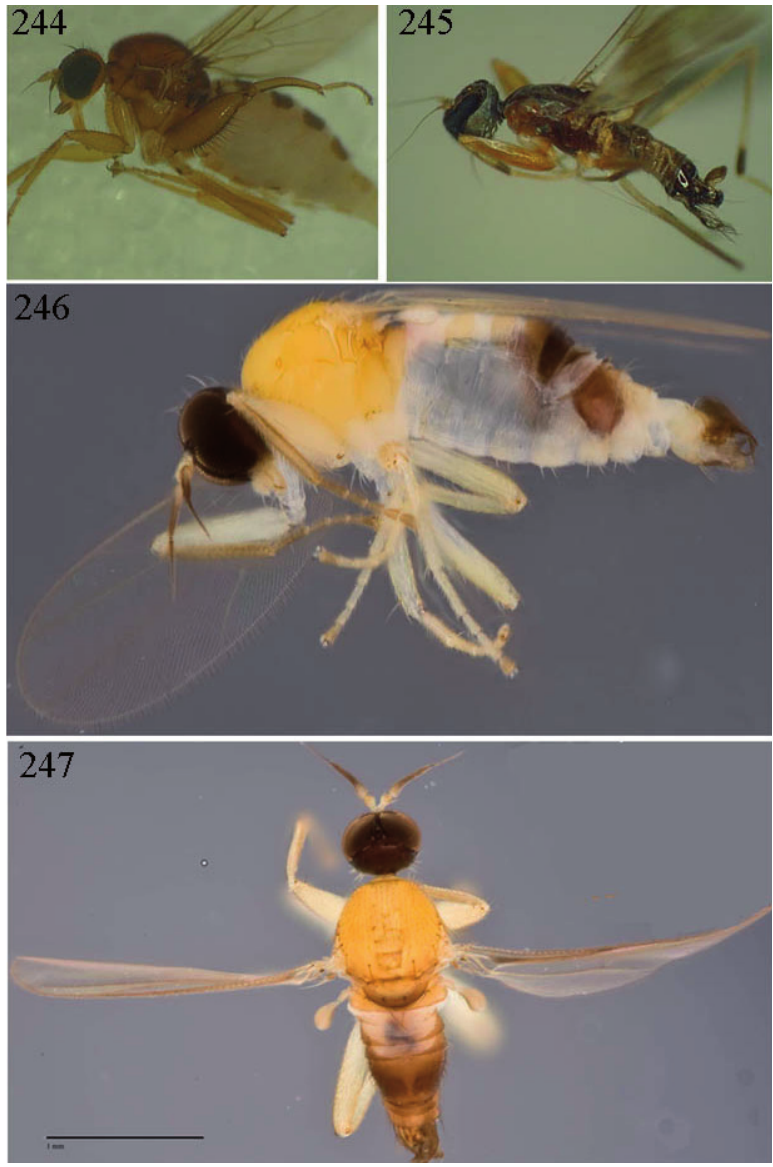
Figs 244-247. Habitus: 244 . Platypalpus singaporensis sp. nov. ♀. 245 . Tachydromia luang Shamshev & Grootaert, 2005, ♂. 246 . Elaphropeza furca Shamshev & Grootaert, 2007, ♂. 247 . Elaphropeza ubinensis Shamshev & Grootaert, 2007,♂